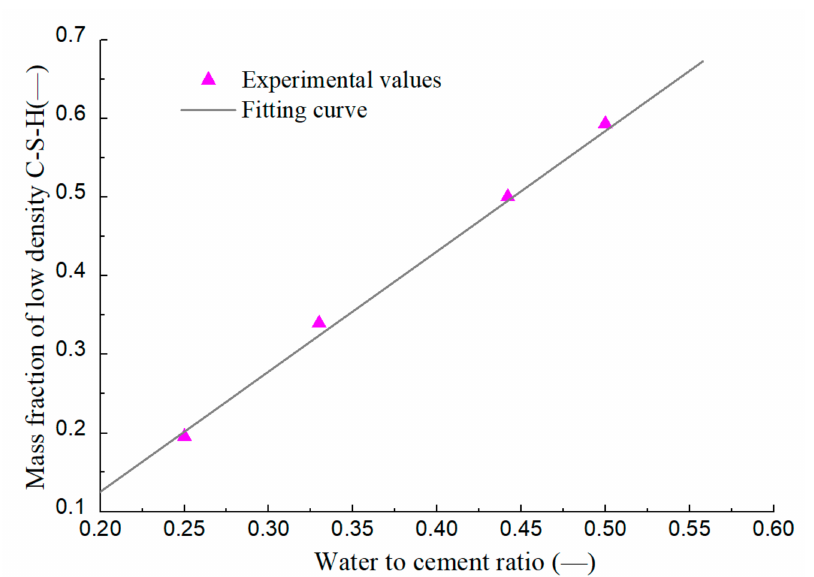
Figure 1. Relationship between mass fraction of low-density C-S-H and w/c of cement